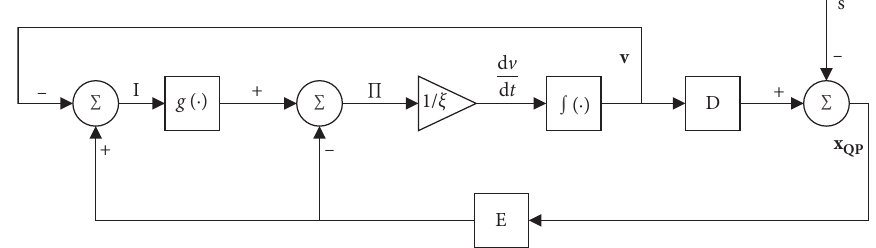
Figure 6: Principle block diagram of SDNN